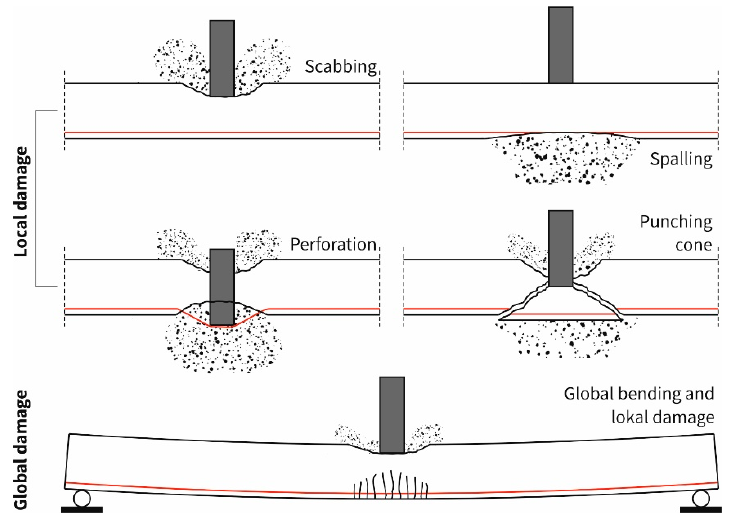
Figure 5. Schematic illustration of the different types of damage; graphic: S. Scheerer.